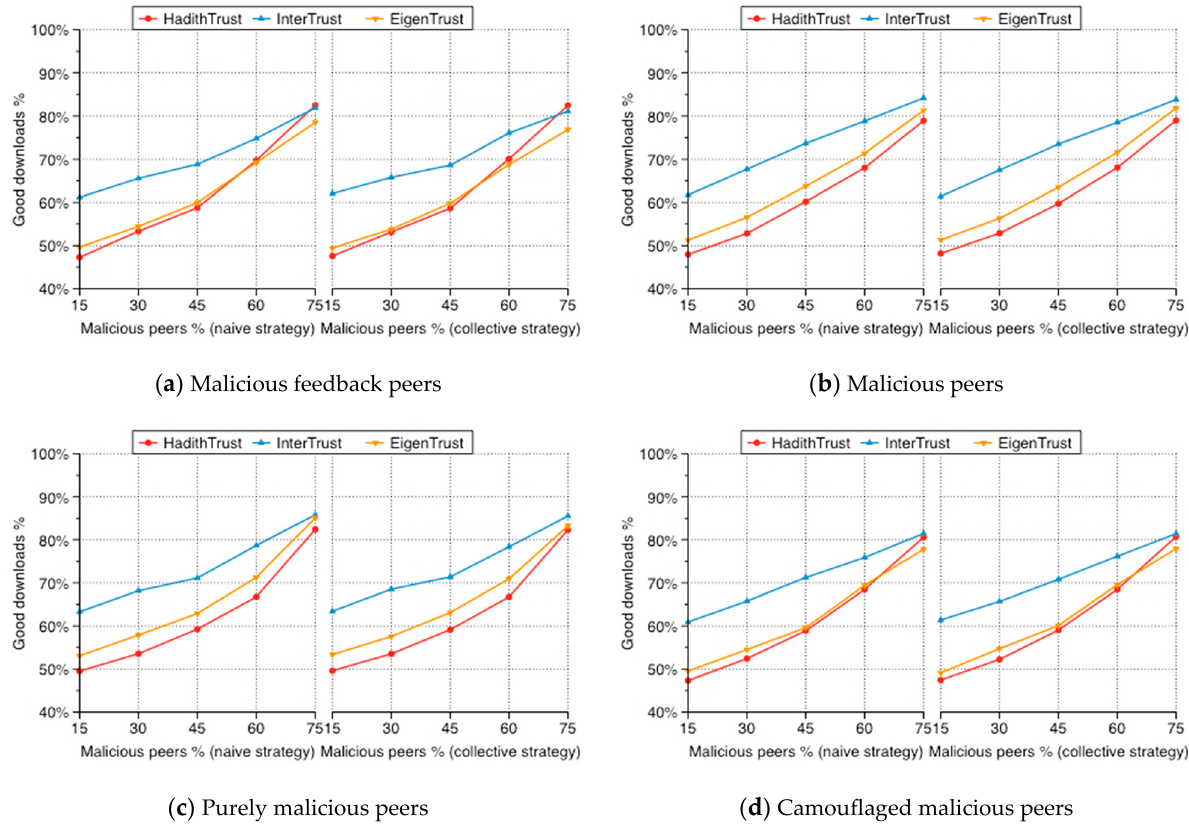
Figure 14. Percentage of good downloads.